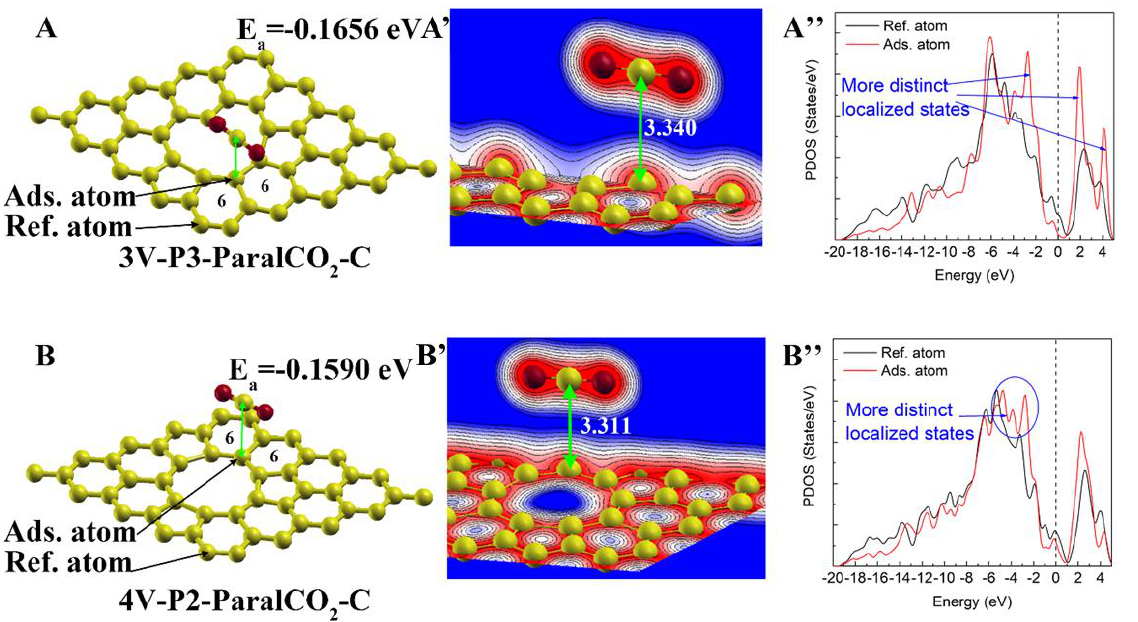
Figure 9. CO 2 physisorption on carbon atoms shared by two 6-membered rings and a vacancy: ( A , A ’) and ( B , B’ ) represent the atomic structure/charge distribution of adsorption on trivacancy (3V) and tetravacancy (4V) defects, respectively. A is the result of 3V-P3-ParaalCO 2 -C, and B is the result of 4V-P2-ParaalCO 2 -C.